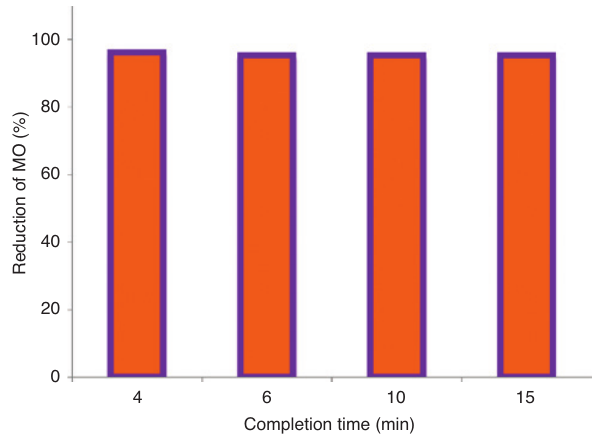
Figure 8: Reusability of CuNPs in the catalytic reduction of